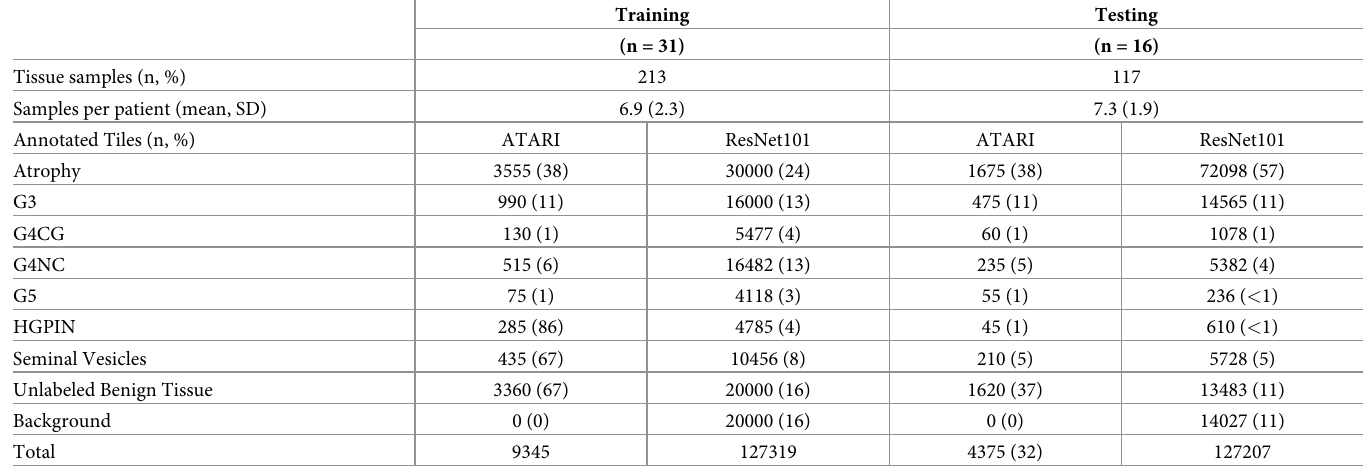
Table 2. Model input